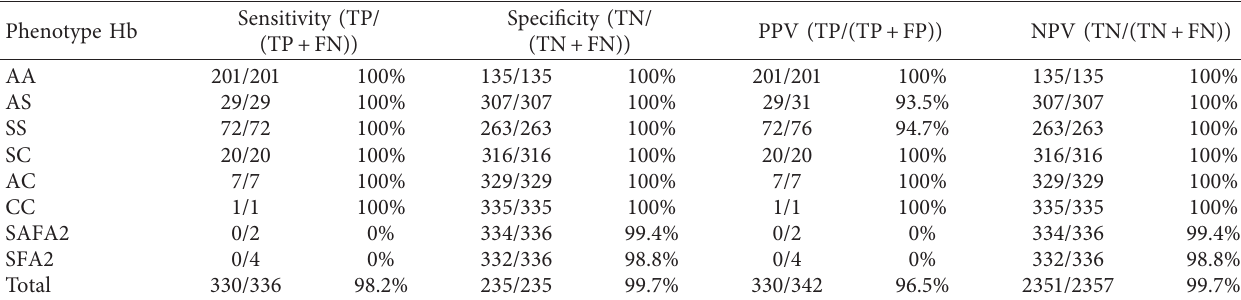
Table 5: Analysis of the hemoglobin phenotypes by HemoTypeSC ™ .